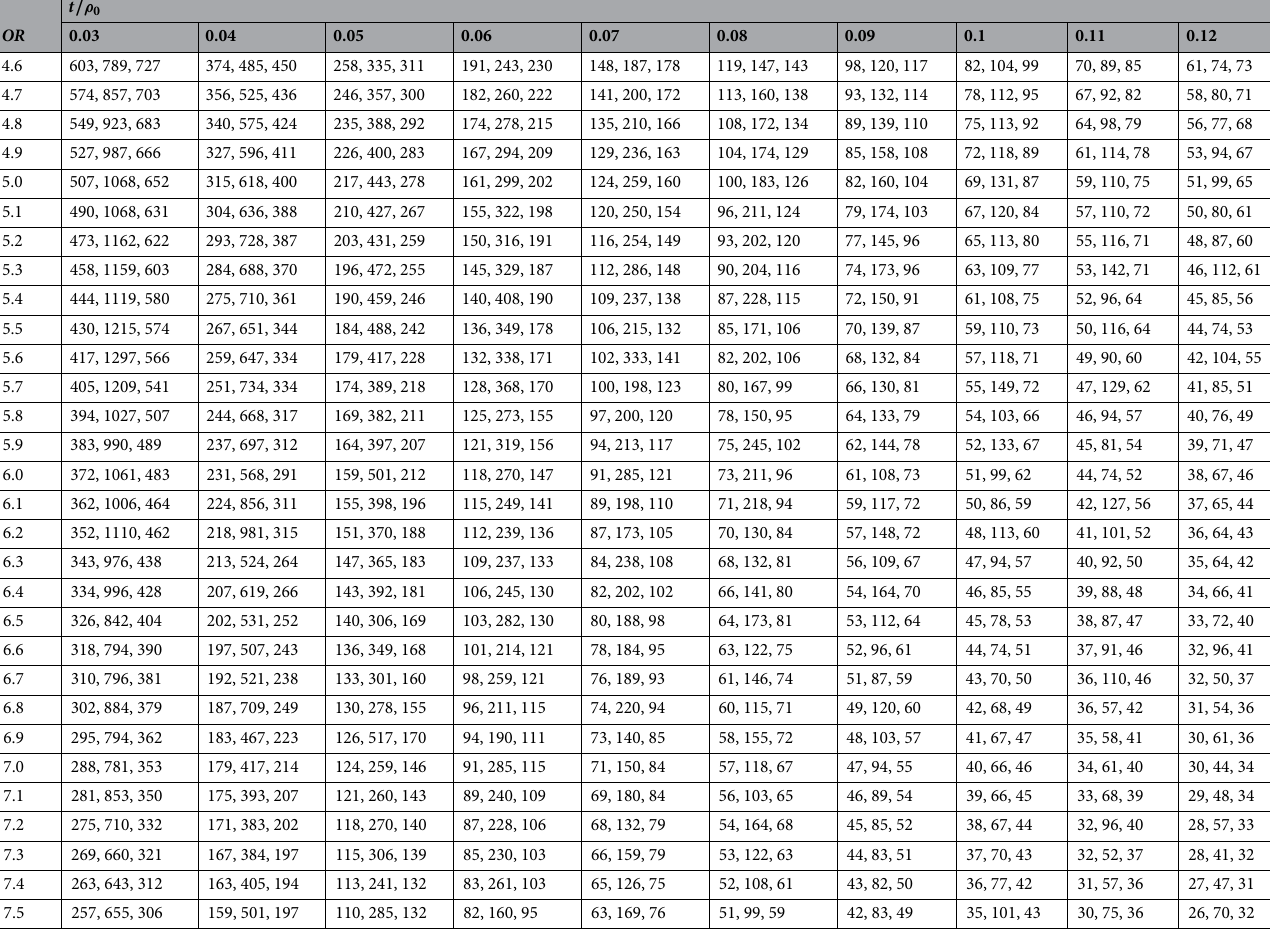
Table 3. Optimum DSP − ( n 1 , n 2 ) for life tests based on Pareto type IV distribution having shape parameters (cid:31) = 2 and η = 0.6 ( r = 0.90). Key: n 1 , n 2 , ASN at p 1